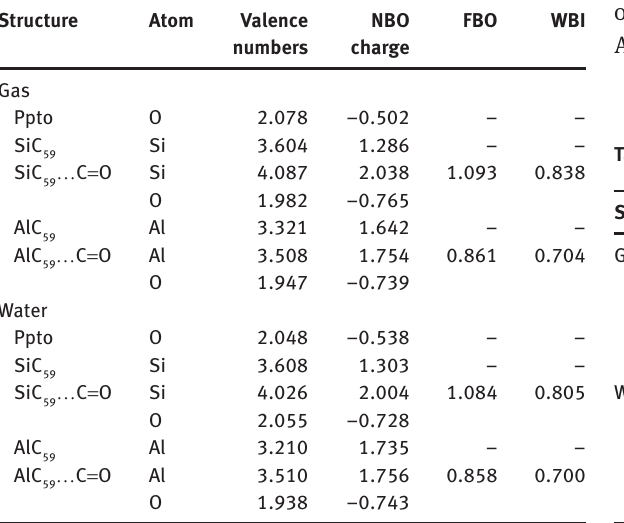
Table 2: Population analyses of the structures. Structure